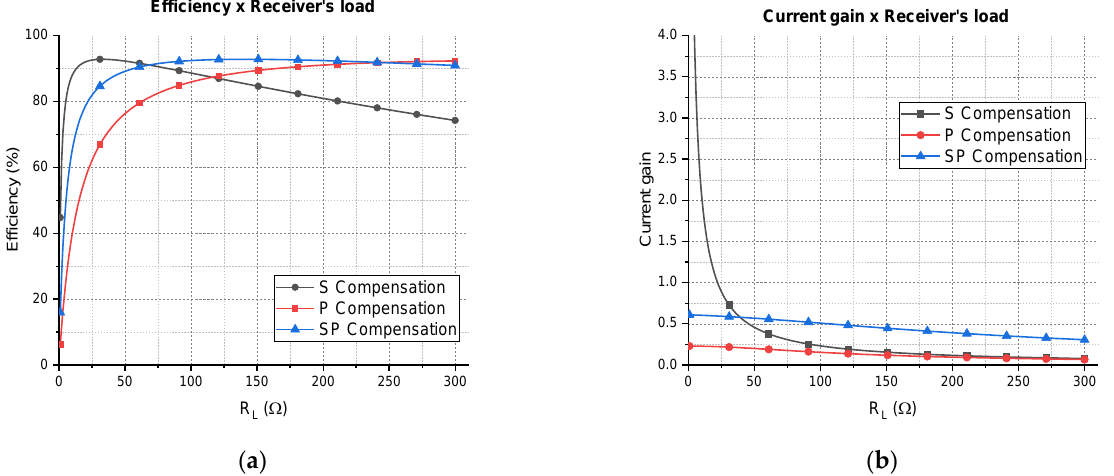
Figure 10. Theoretical results of the S, P, and SP topologies are represented as plots of ( a ) efficiency vs. load resistance; ( b ) current gain (ratio between the current through the load and the current thought the Tx coil) vs. load resistance.